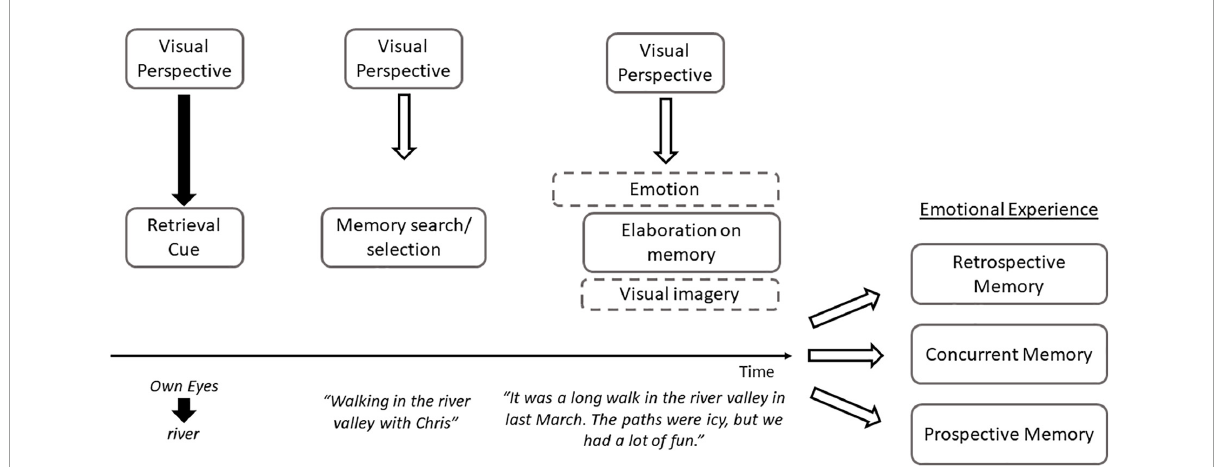
FIGURE1 The impact of visual perspective shifts on emotional experiences during AM retrieval. Specifically, the model emphasizes that the presentation of a visual perspective cue (own eyes/observer) influences how the retrieval cue is processed, which biases later stages of retrieval, namely, the memory search/selection process and elaboration on memory details. Shifting to a novel perspective influences emotional experiences attached to the encoding context (retrospective memory), during retrieval (concurrent memory), and during subsequent retrieval (prospective